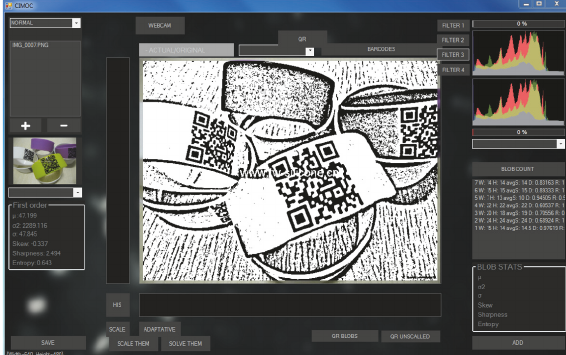
Figure 10: GUI of the designed application for evaluating proposed approach for QR code